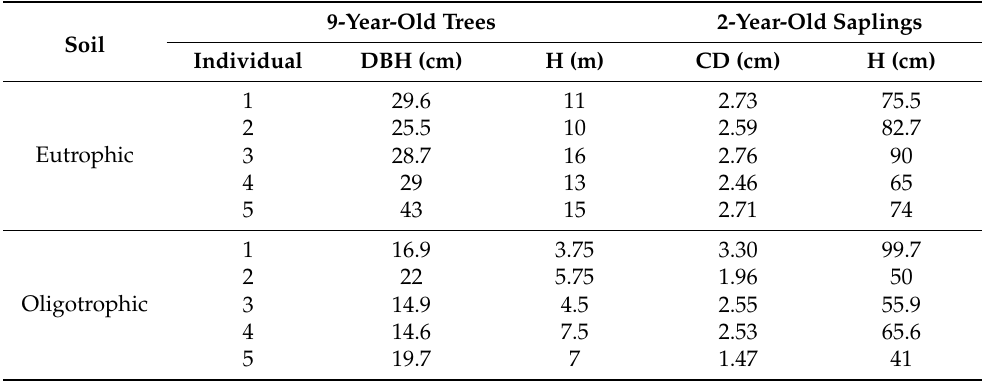
Table 2. Studied trees and saplings of Enterolobium contortisilliquum . DBH = diameter at breast height; H = height; CD = collar